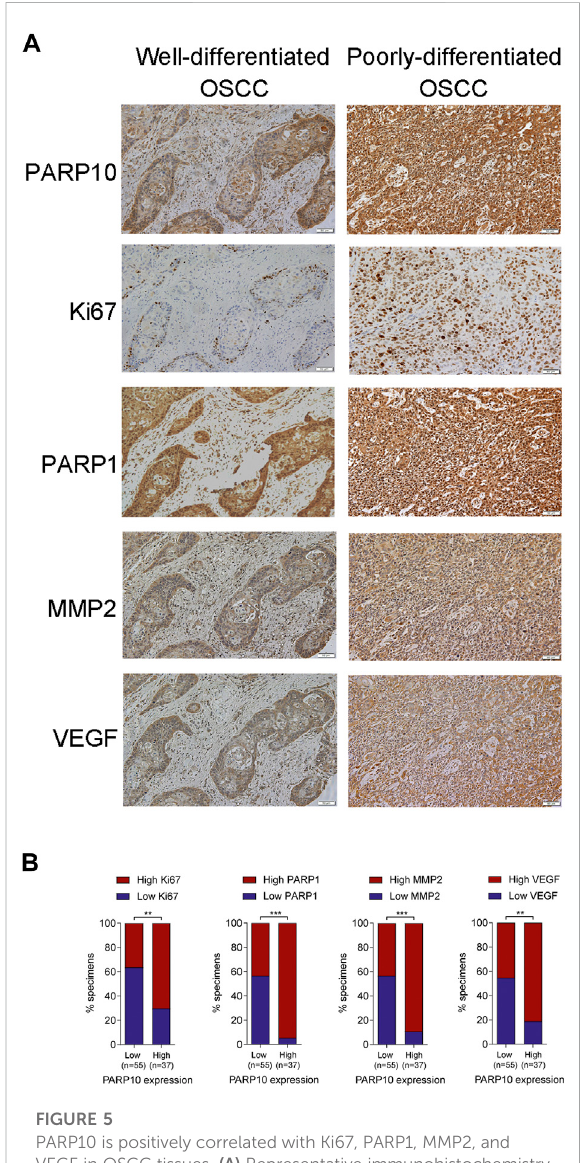
FIGURE 5 PARP10 is positively correlated with Ki67, PARP1, MMP2, and VEGF in OSCC tissues. (A) Representative immunohistochemistry images for PARP10, Ki67, PARP1, MMP2, and VEGF in OSCC specimens. (B) The correlation between PARP10 expression and the indicated proteins was analyzed using the χ 2 test. ** p < 0.01, *** p <